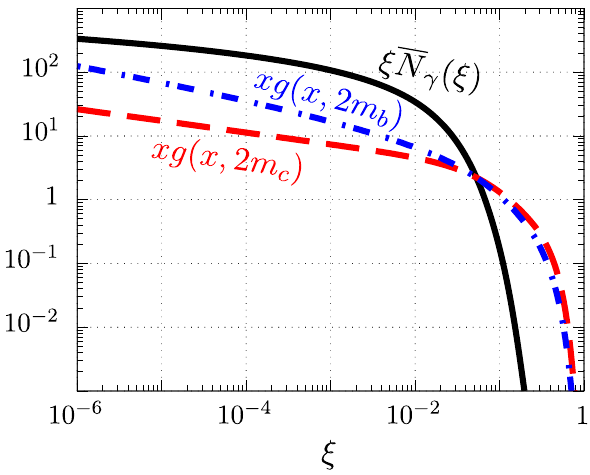
Fig. 2 Thenumberdistributionofphotons N γ (ξ) (times ξ )outsidethe nucleus that can interact with gluons in the proton in the considering photoproductionprocess.Forcomparison,thegluondistributionsattwo factorization scales 2 m c and 2 m